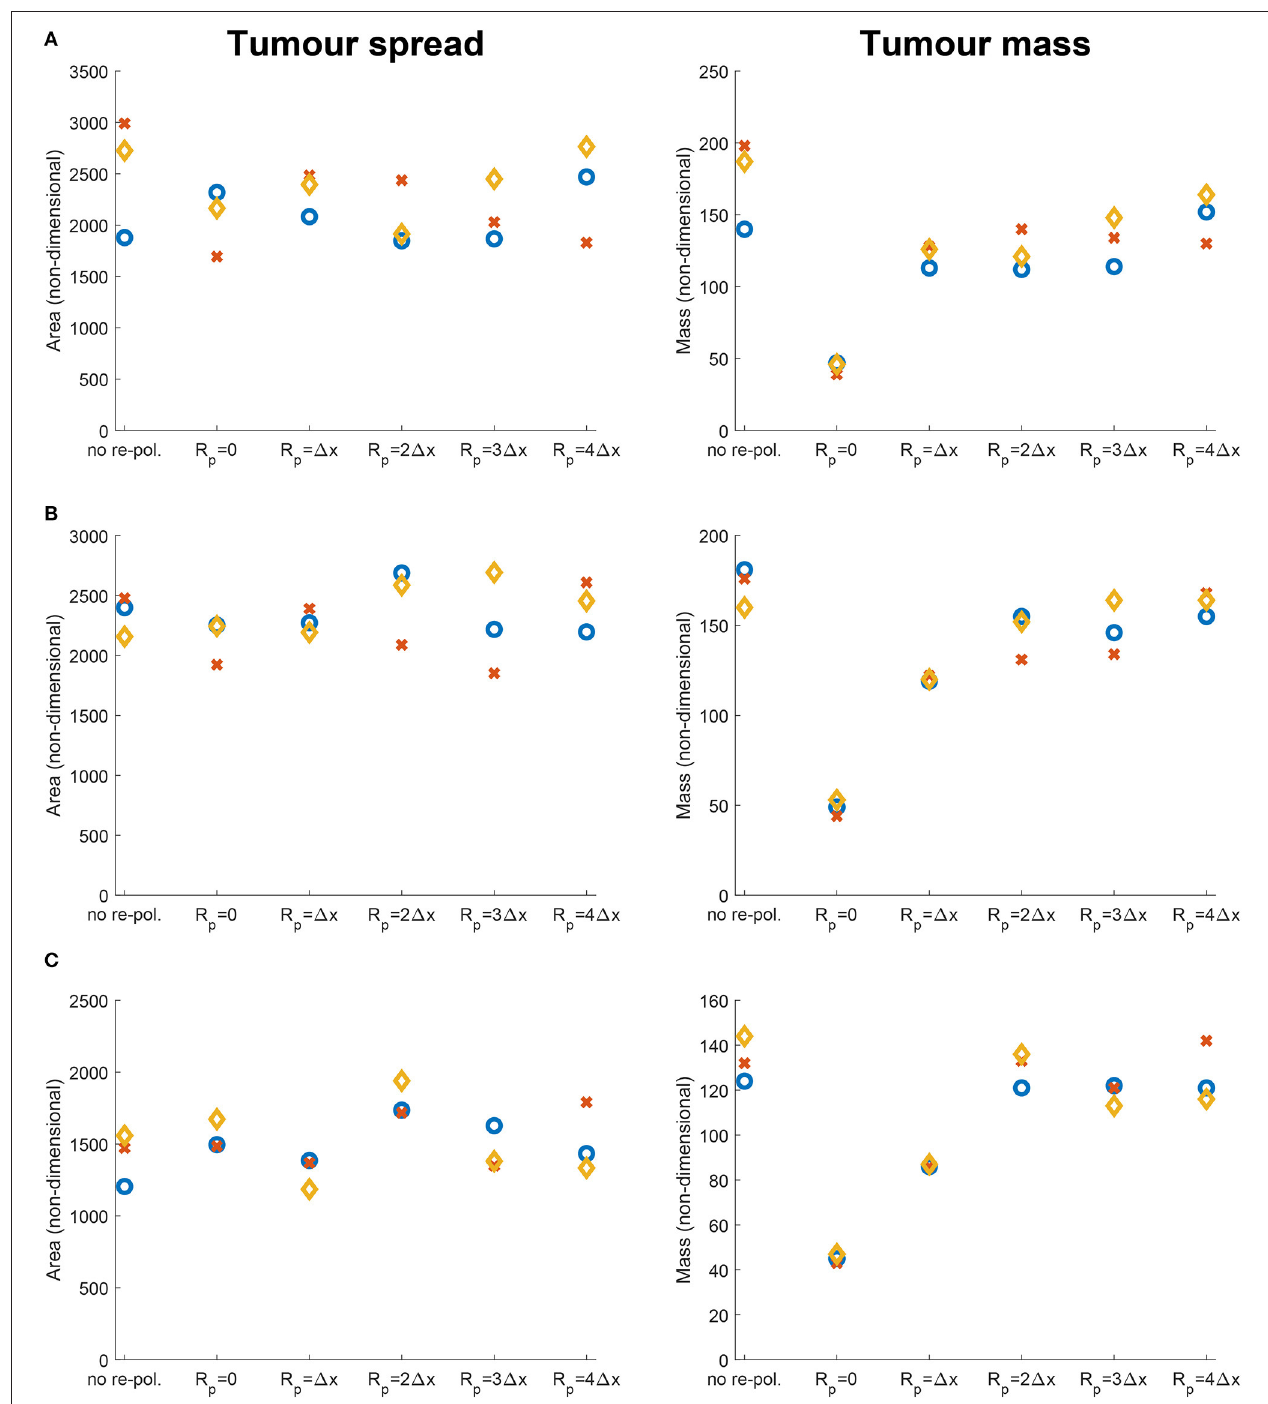
FIGURE 9 | Results of varying the radius of the re-polarisation domain R p ∈ { 0, 1 x ,2 1 x ,3 1 x ,4 1 x } with starting time t p = 0. Left panel shows the change in the tumour spread and the right panel shows the change in tumour mass with respect to R p . Here the blue circles correspond to a high ECM degradation rate by cancer cells ( β lc = 3.0, β Fc = 1.5, α c = 0.625), the orange diamonds to a medium ECM degradation rate ( β lc = 2.0, β Fc = 1.0, α c = 0.42) and the red crosses to a low degradation rate ( β lc = 1.0, β Fc = 0.5, α c = 0.21). The environment controller β is set to (A) β = 0.75, (B) β = 0.7875, and (C) β =